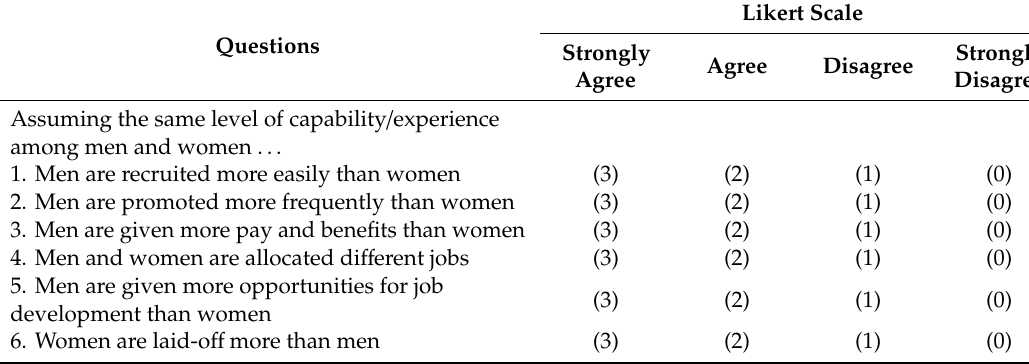
Table 1. Workplace Gender Discrimination Scale. Questions